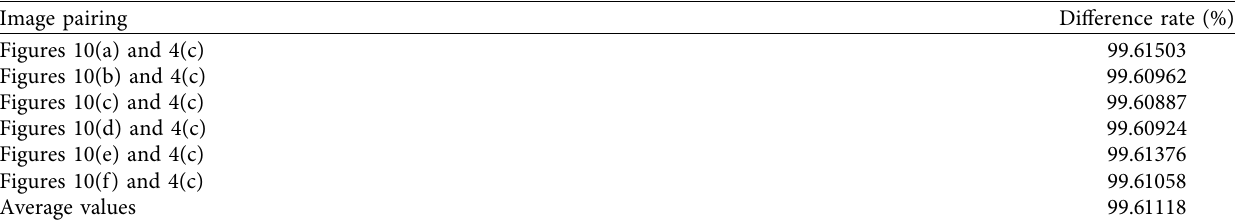
Table 6: Pixel difference rate for pairings of decrypted composite image (i.e., using the actual key parameters (in Figure 4(c)) and